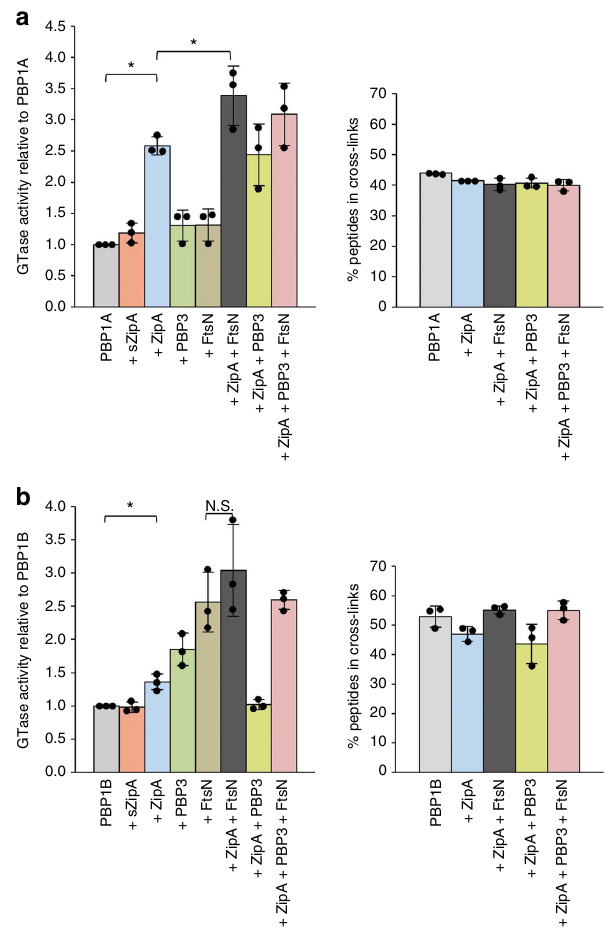
Fig. 3 ZipA stimulates the GTase but not TPase activity of PBP1A and PBP1B. Synthetic activities of PBP1A ( a ) and PBP1B ( b ) in the presence of different interacting partners. GTase activity (left panels) was measured as the consumption of dansylated lipid II substrate by PBP1A or PBP1B. The GTase rates are shown as mean ± s.d. of three independent experiments, after normalisation to PBP1A or PBP1B alone values. TPase activities (right panels) were determined by the percentage of peptides in cross-links present in newly synthesised PG by PBP1A or PBP1B using radiolabelled lipid II substrate, and they are shown as mean ± s.d. of three independent experiments. The corresponding dot plots ( fi lled circles) are overlaid in each bar chart. Student ’ s t -test (two-tailed) was used for statistical analysis (N.S. not signi fi cant; * P <